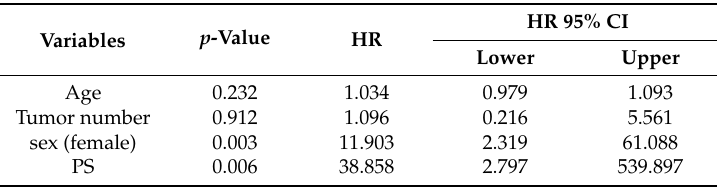
Table 3. Variables affecting overall survival.